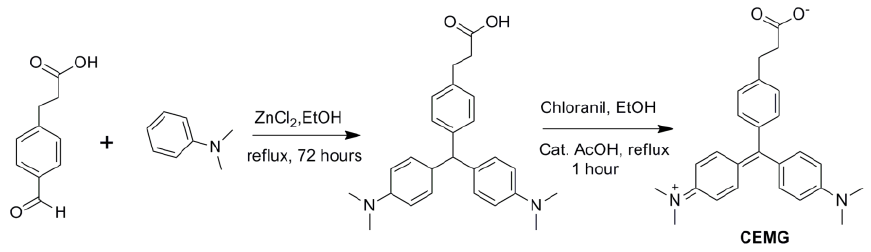
Figure 4. Synthetic scheme of the CEMG.